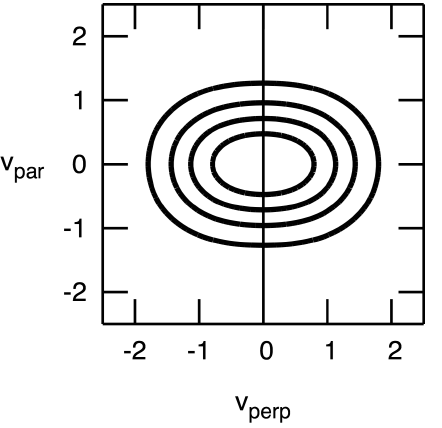
Fig. 2. Apparent temperature anisotropy in dependence on the nor- malized amplitude b of a wave with ω = 2 π/T . The evaluation of the anisotropy according to Eq. (21) is shown for different values of the plasma beta.